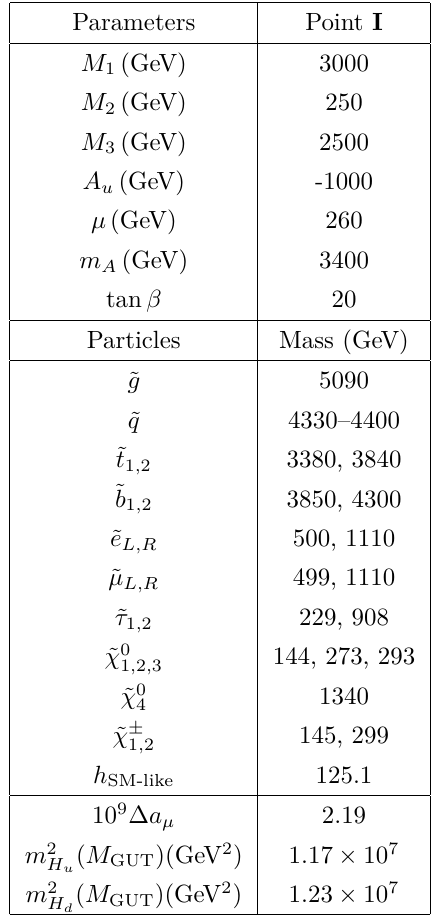
Table 1 . A mass spectrum in the model A . We take M N